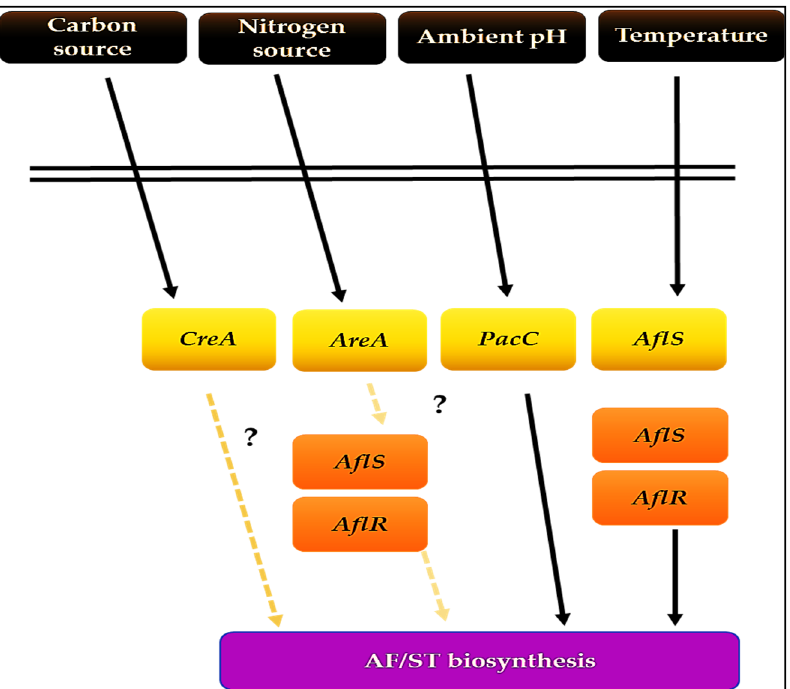
Figure 7. Ecological factors affecting AF/ST production. Dots signify links that have yet to be proven